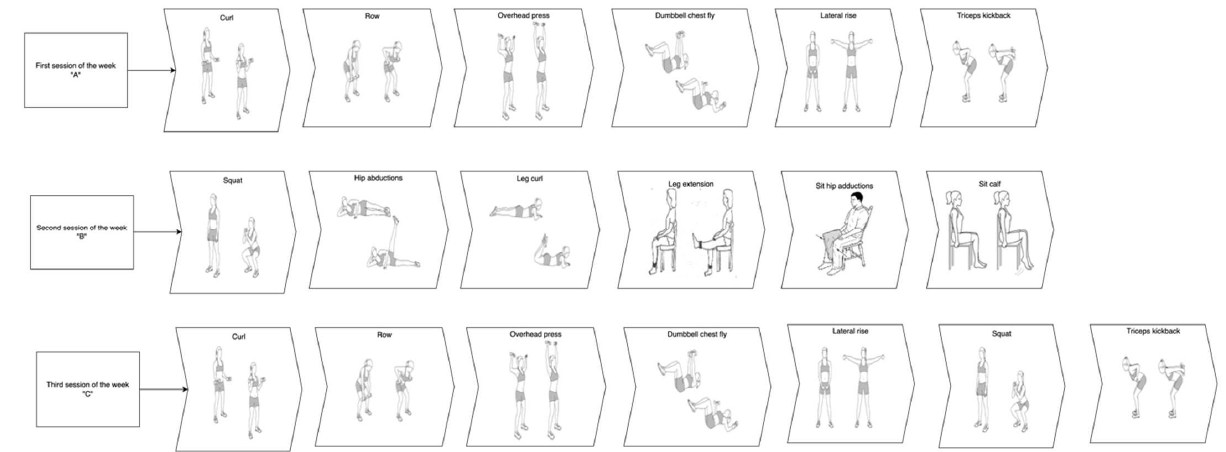
Figure 1. Graphical representation of each exercise performed by study participants in the three different weekly sessions. Note, each exercise could be performed with the support of a chair if the participant needed it. Table 1. Training sessions (A, B, and C) exercises and progressions.